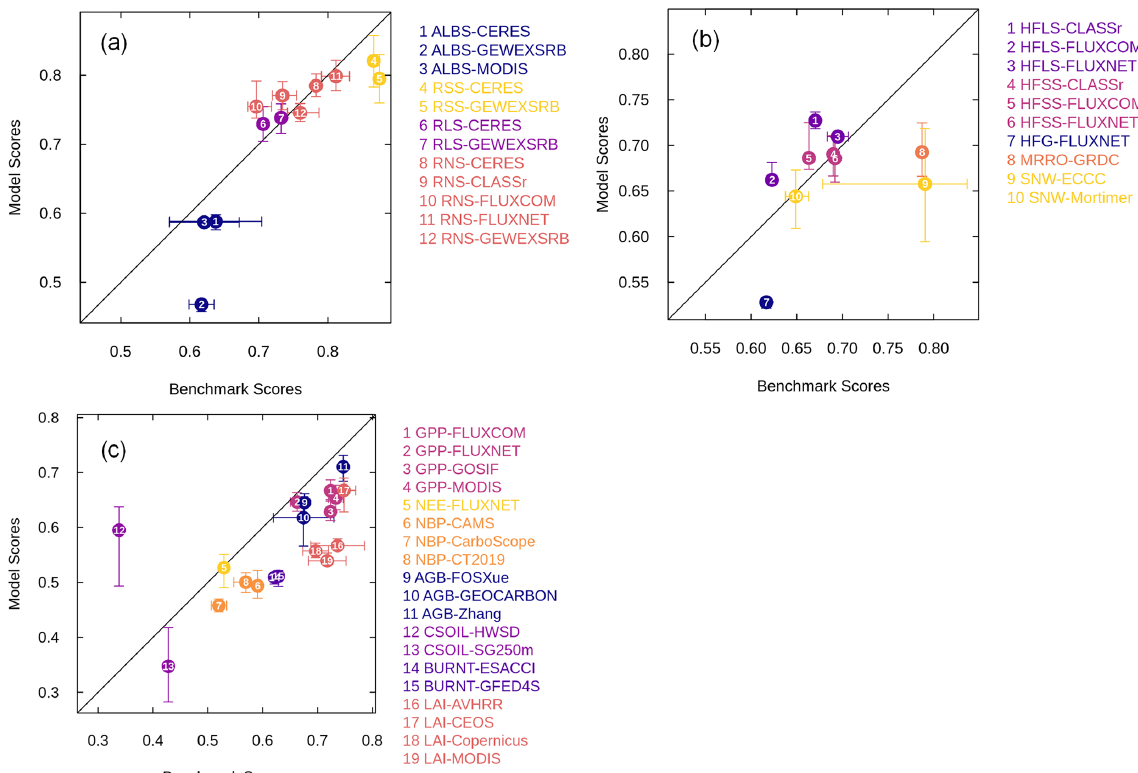
Figure 10. Comparison of benchmark scores with model overall scores for a range of energy-, water-, and carbon-related quantities. The whiskers indicate the range for benchmark scores across different observation-based data sets and the range across the eight model simulations for the overall model scores. The quantities in (a) are ALBS (surface albedo), RSS (net shortwave radiation), RLS (net longwave radiation), and RNS (net radiation). Quantities in (b) are HFLS (latent heat flux), HFSS (sensible heat flux), HFG (ground heat flux), MRRO (runoff), and SNW (snow water equivalent). Quantities in (c) are GPP (gross primary productivity), NEE (net ecosystem exchange), NBP (net biome productivity), AGB (aboveground biomass), CSOIL (soil carbon mass), BURNT (area burned), and LAI (leaf area